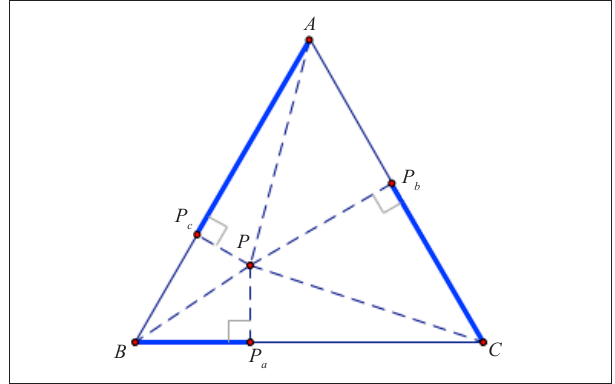
FIGURE 1: Clough’s conjecture: AP